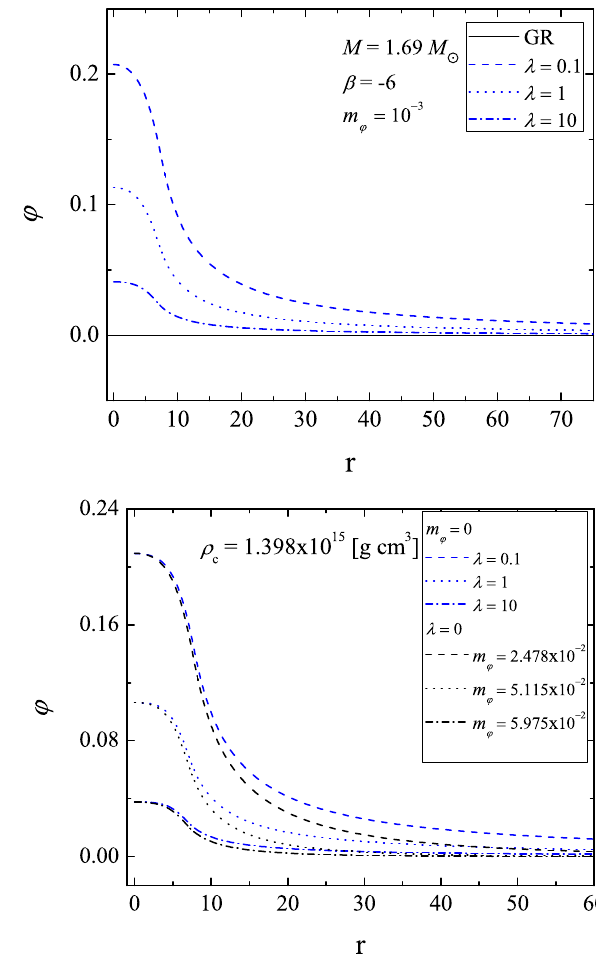
Fig. 2 (Top) Mass as function of the central density of the models. The results are for GR (black), and β = − 6 with m ϕ = 10 − 3 and different values for λ (blue in different patterns). (bottom) The central value of the scalar field as a function of the central density of the model. The models are with β = − 6 (blue) and β = − 10 (purple), m ϕ = 10 − 3 and different values for λ (in different patterns)